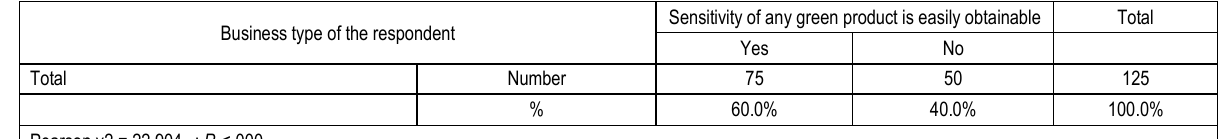
Table 2.(cont.) Connection between business type and sensitivity of any green product. Business type of the respondent